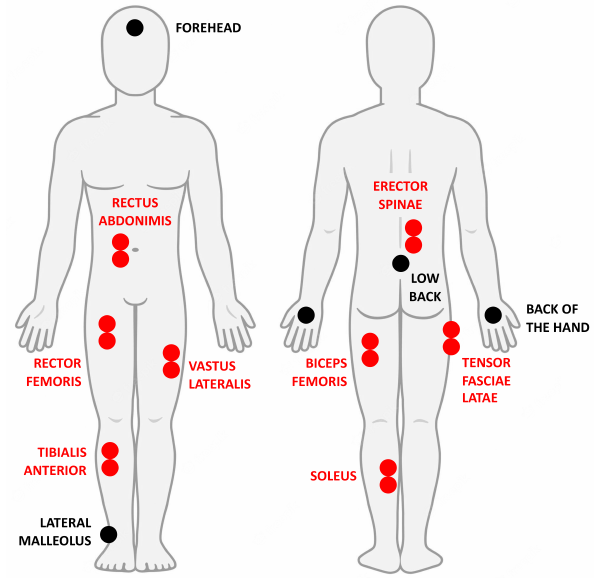
Figure 7. Locations of retro-reflective markers (black) and EMG electrodes (red). EMGs were placed on both sides of the